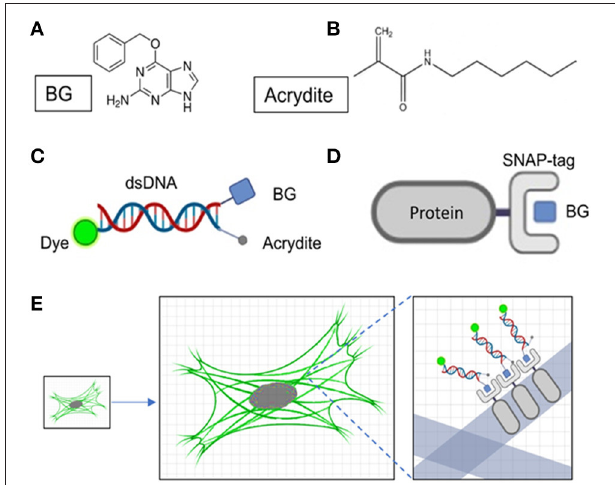
FIGURE 1 | Design of DNA oligostrands and schematic diagram of SNAP-benzoylguanine (BG) staining. (A) Molecular formula of BG. (B) Molecular formula of Acrydite. (C) Schematic diagram of the designed DNA oligostrands. (D) Schematic diagram of SNAP-tag protein binding to BG. (E) Staining and expansion of the DNA